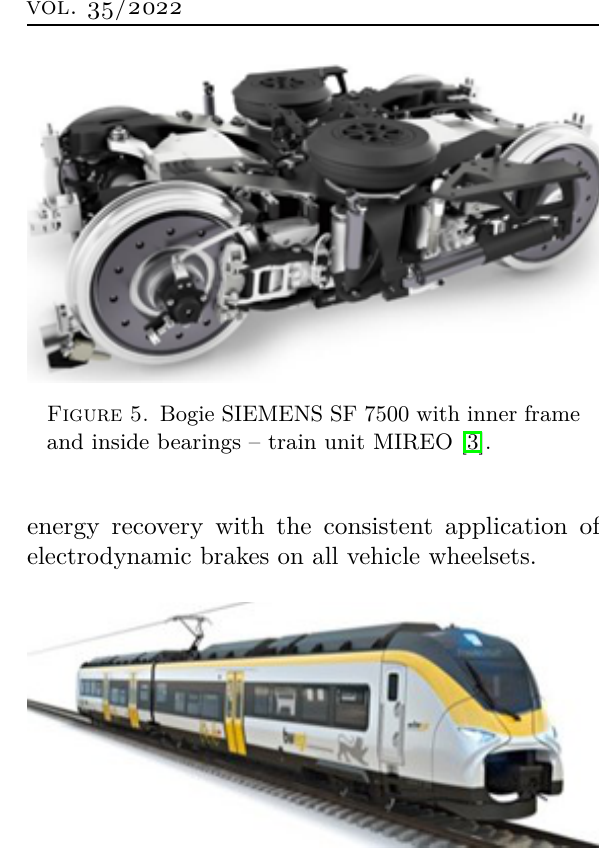
Figure 6. Electric regional unit MIREO [3].